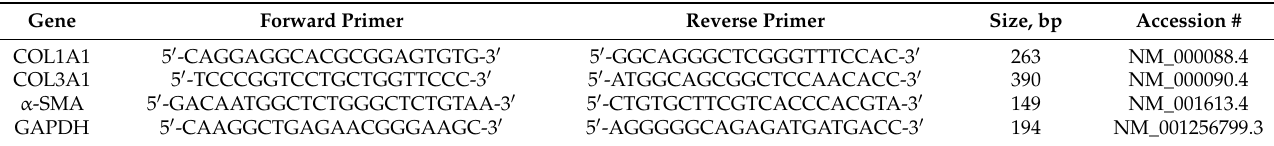
Table 1. List of primer sequences used in this